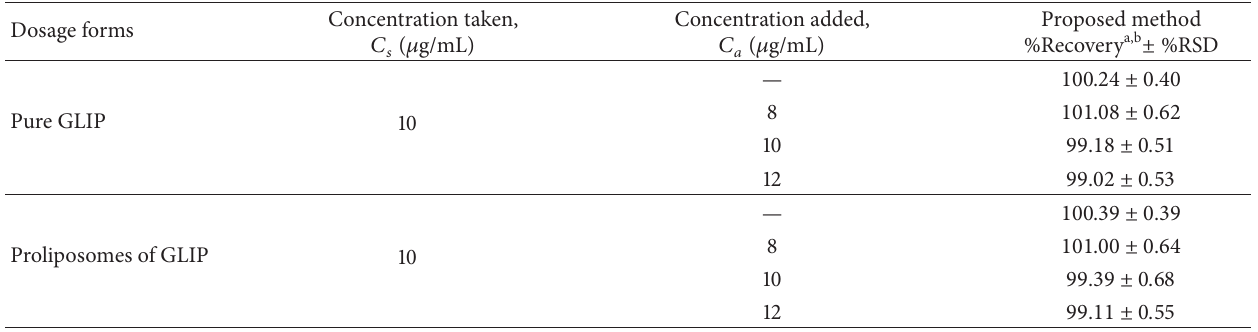
Table 4: Recovery of the proposed method (standard addition method, 𝑛 = 6 ).